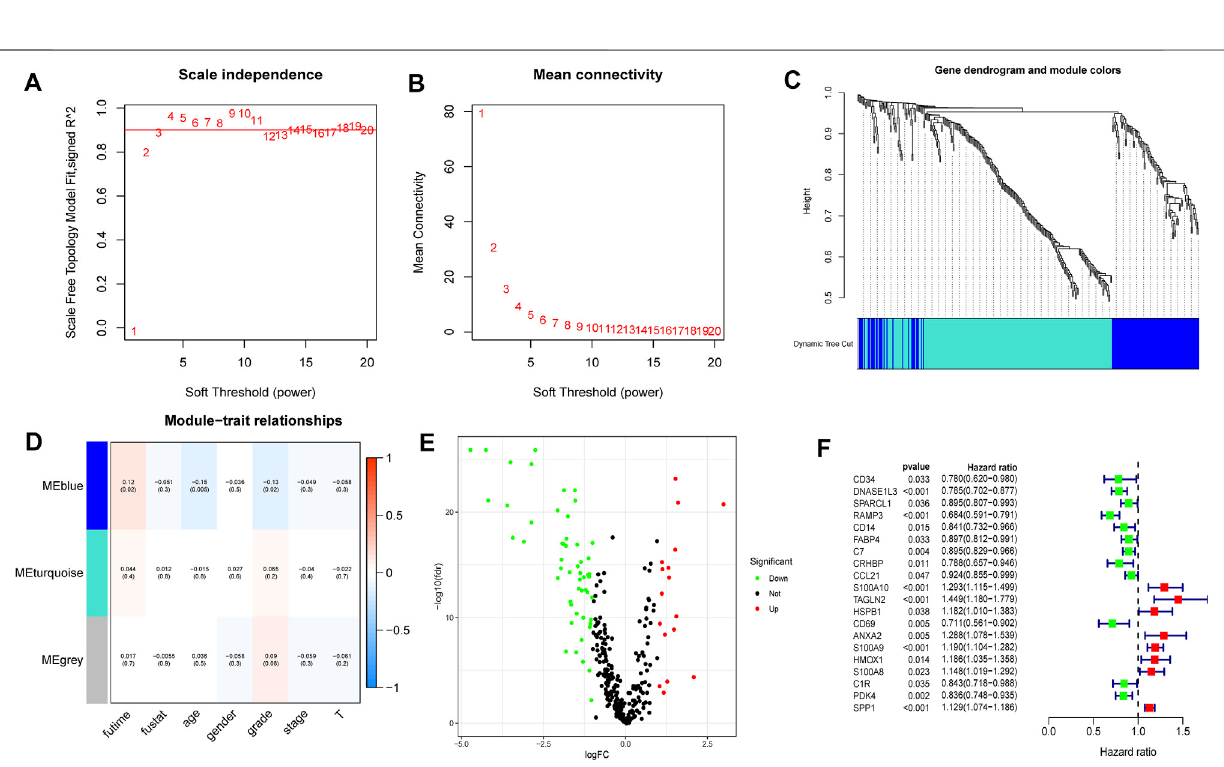
Frontiers in Genetics |